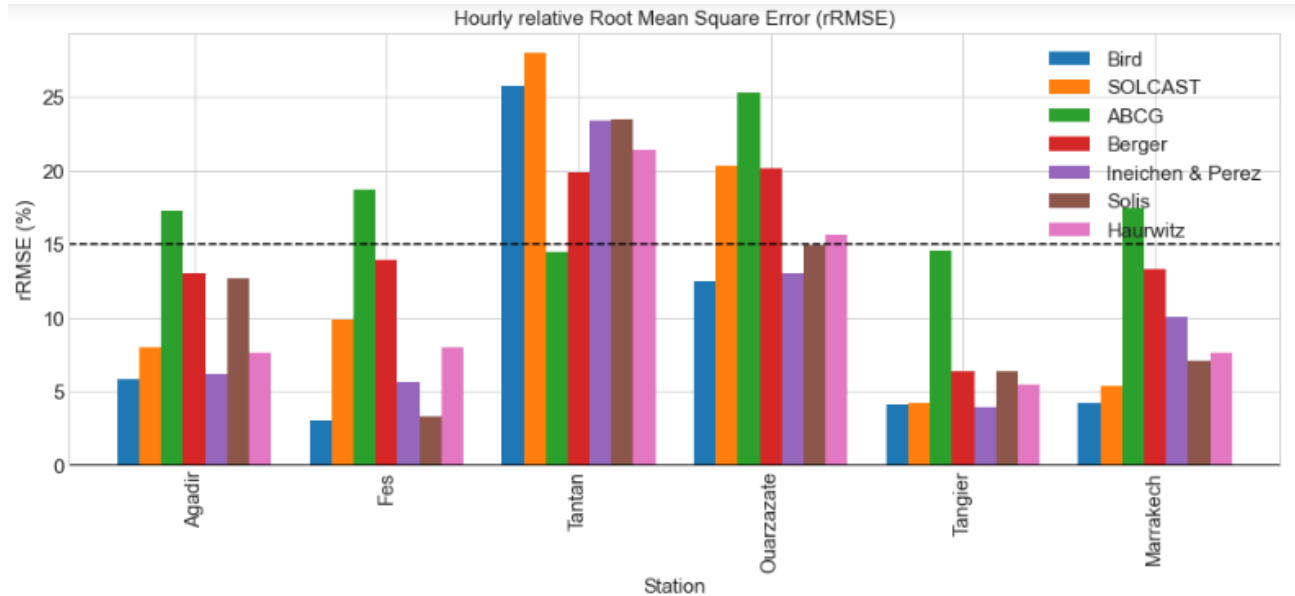
Figure 4. Hourly relative root mean square error (rRMSE) of modelled clear sky GHI against McClear clear sky GHI.